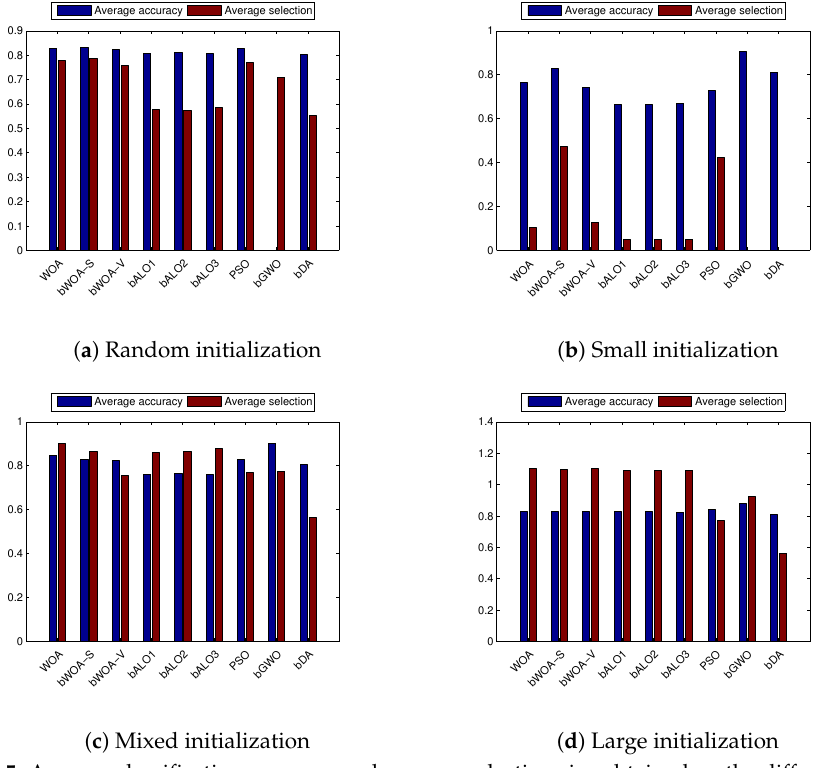
Figure 5. Average classification accuracy and average selection size obtained on the different datasets averaged for the compared algorithms over the three initialization